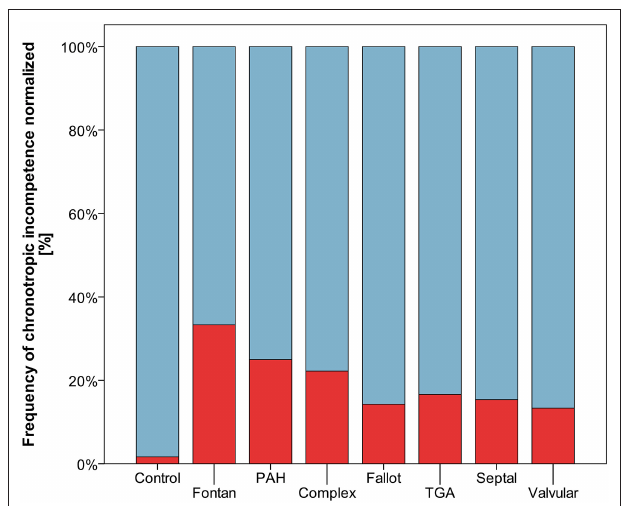
FIGURE 1 | Chronotropic index [Chronotropic index = (peak heart rate–resting heart rate)/(220–age–resting heart rate)] of control group vs. congenital heart disease (CHD) subgroups. Dashed line marks chronotropic incompetence threshold of 0.8. * p < 0.05, ** p < 0.001. Boxplot bottom indicates 25th, top of the box 75th percentile. Whiskers extend to 1.5 times of box height or to minimum/maximum value. Outliers are shown as points.